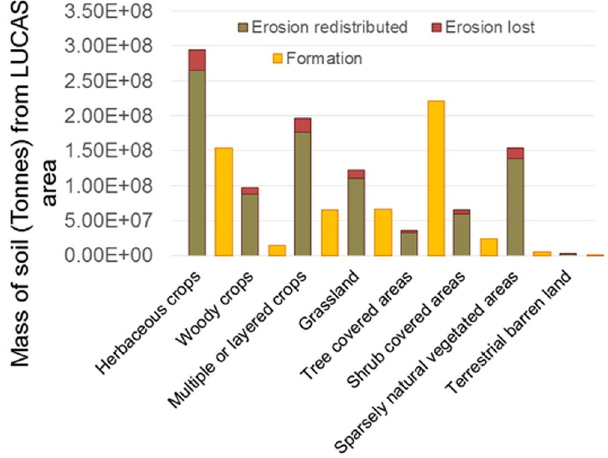
Figure 3. Estimated soil erosion across the EU-25 study area, with an attempt to divide the erosion into that which is redistributed on land and that which ends up in surface water and ultimately the ocean. Soil formation is estimated based on a potential upper bound for formation of 1.4 (t ha − 1 ) based on Verheijen et al . 30